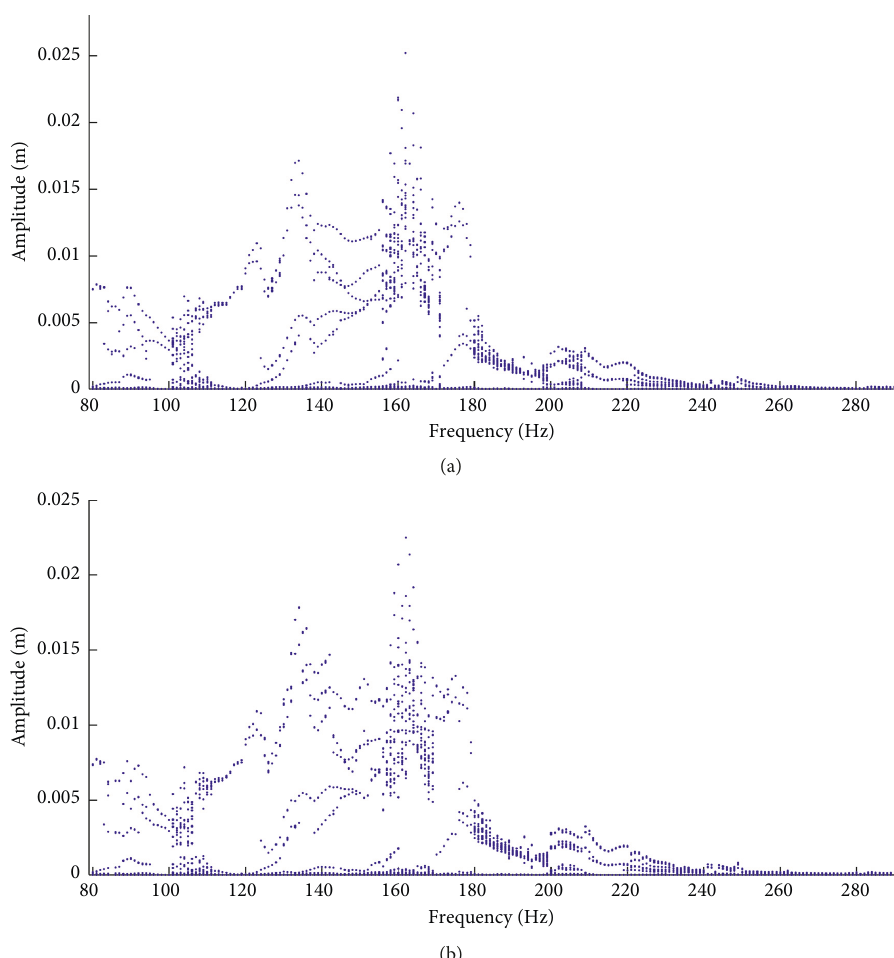
Figure 9: Bifurcation diagram with twenty-mode discretization: damping ratio ξ � 0 . 02 and hard impact k ∗ � 13000 ( k � 1 × 10 7 N/m ) . (a) Bifurcation diagram using FIM. (b) Bifurcation diagram using